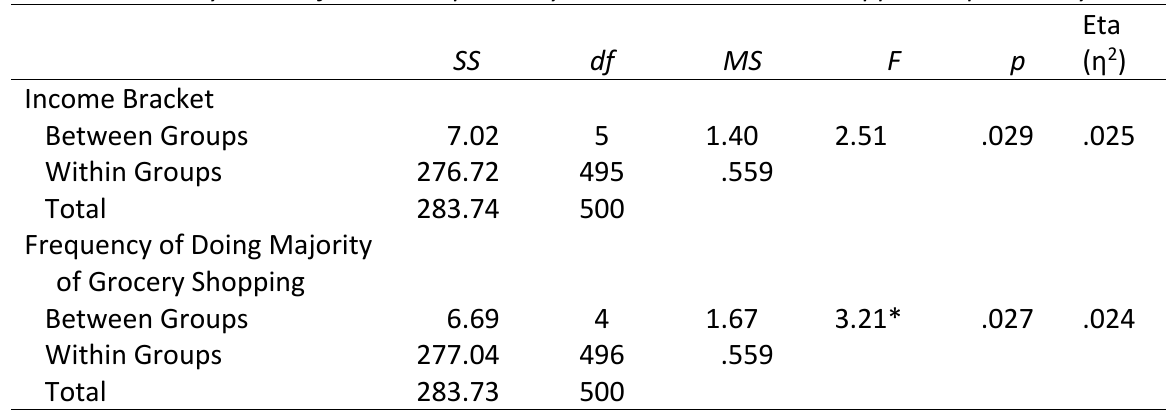
ANOVA Summary Table of GM Perceptions by Income Bracket and Shopper